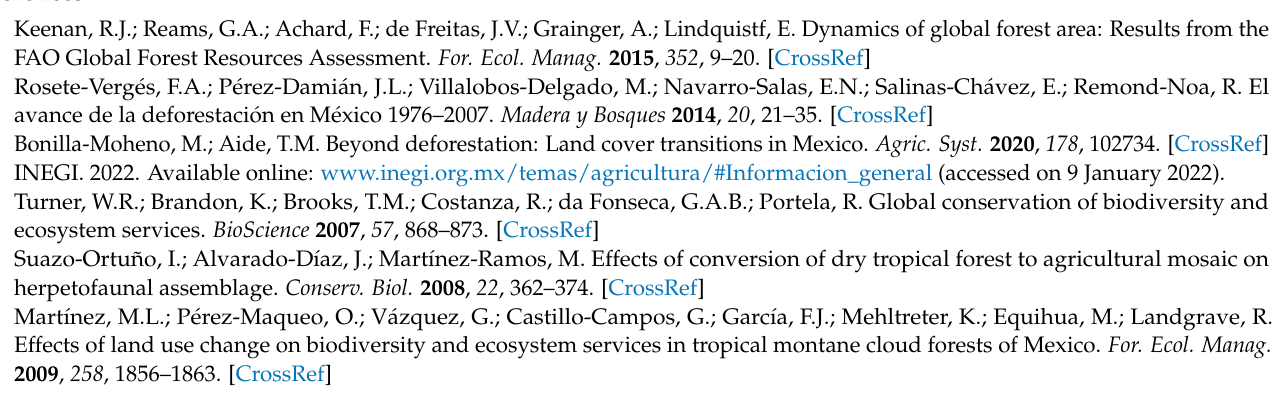
Table S5: Results of the DistLM marginal and sequential tests to get the best predictable model between amphibian species composition and environmental variables across land cover/use